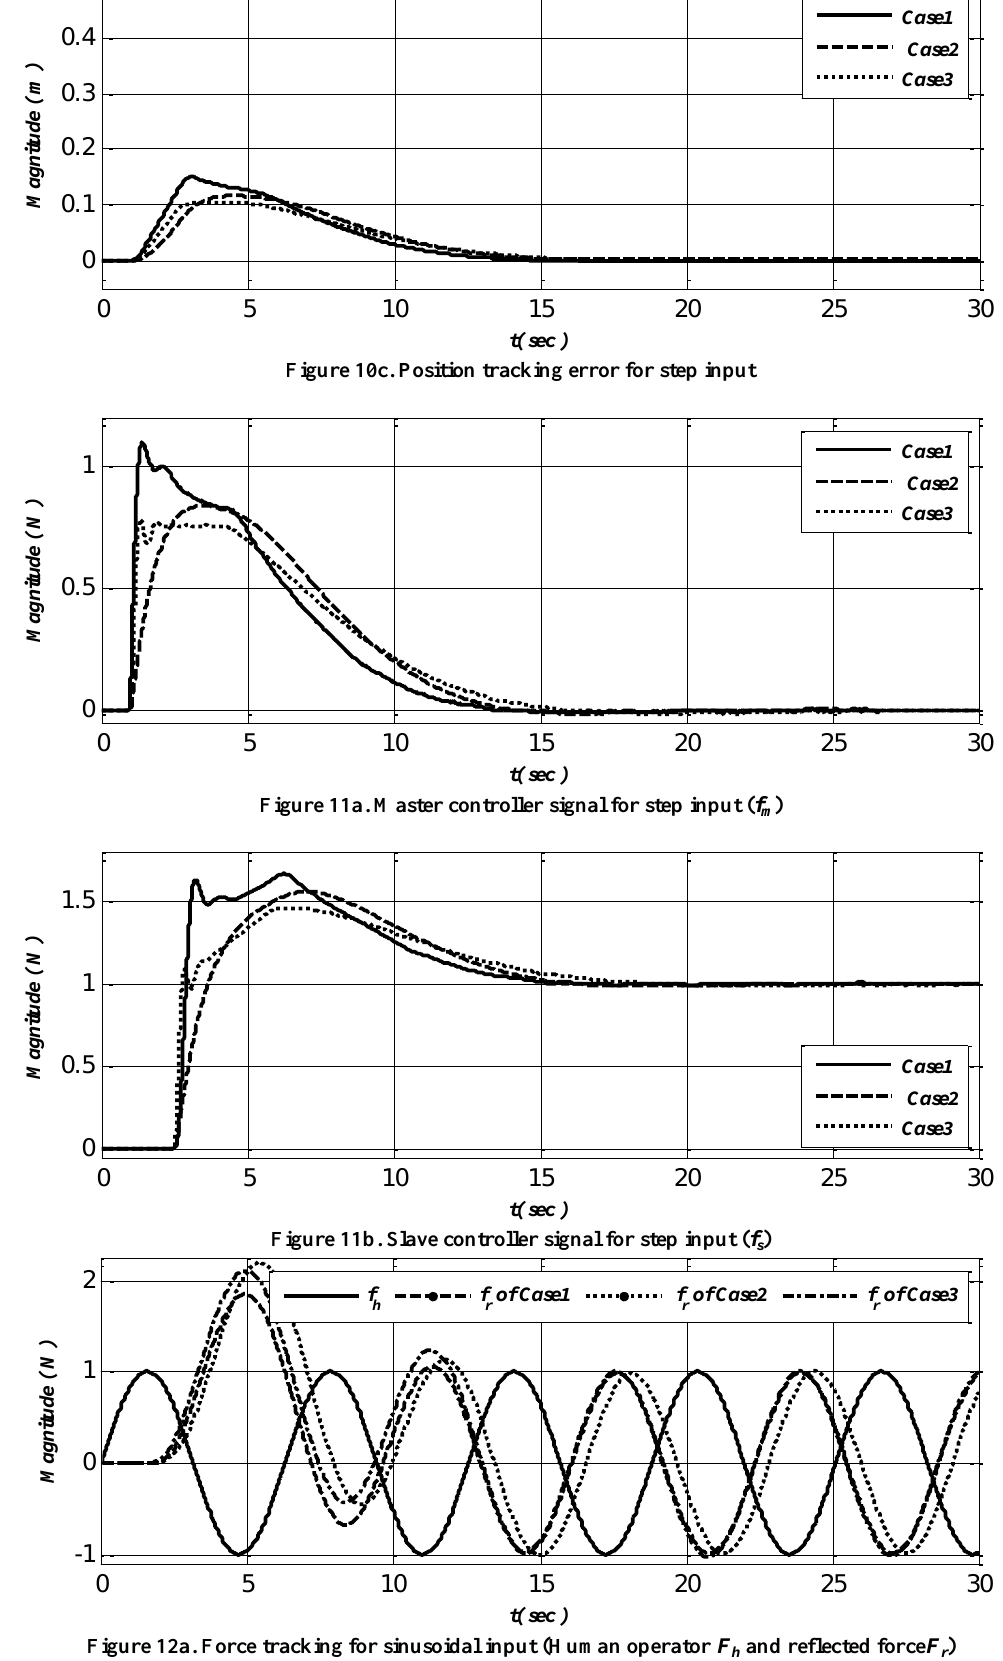
Figure 12a. Force tracking for sinusoidal input (Human operator F h and reflected force F r